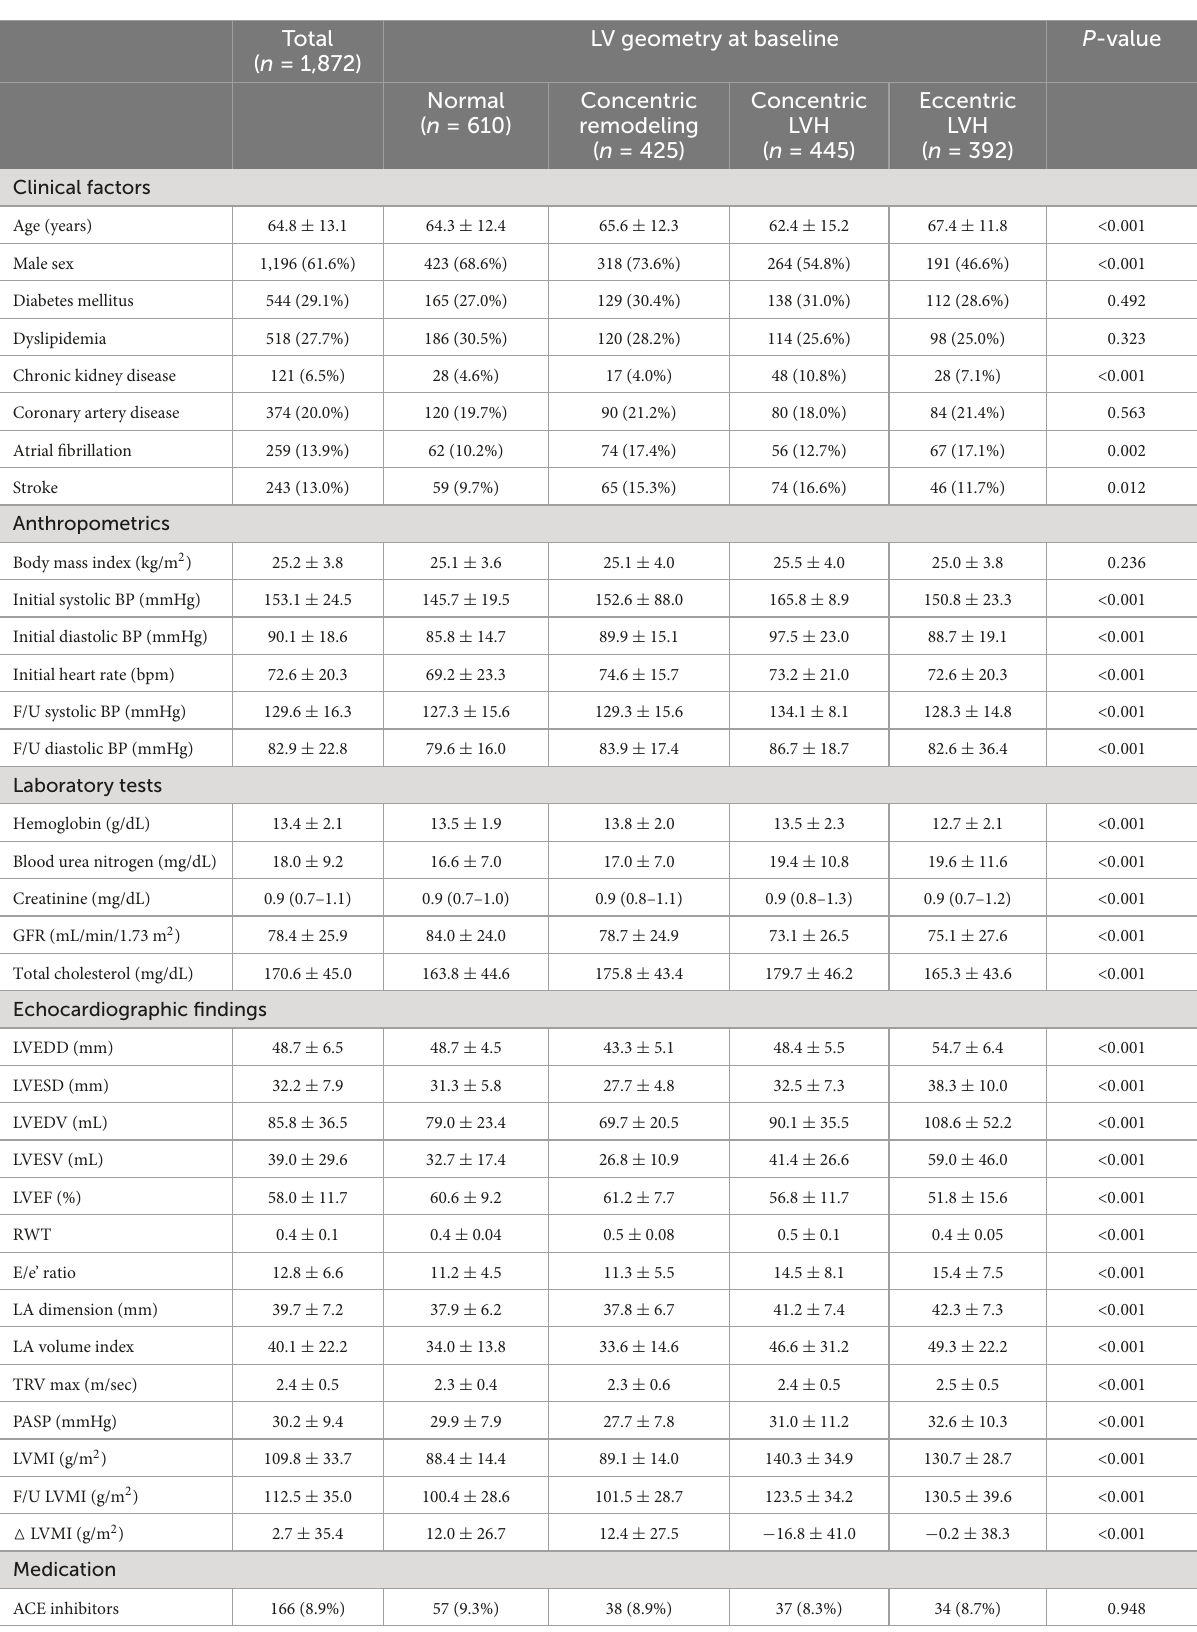
TABLE 1 Baseline